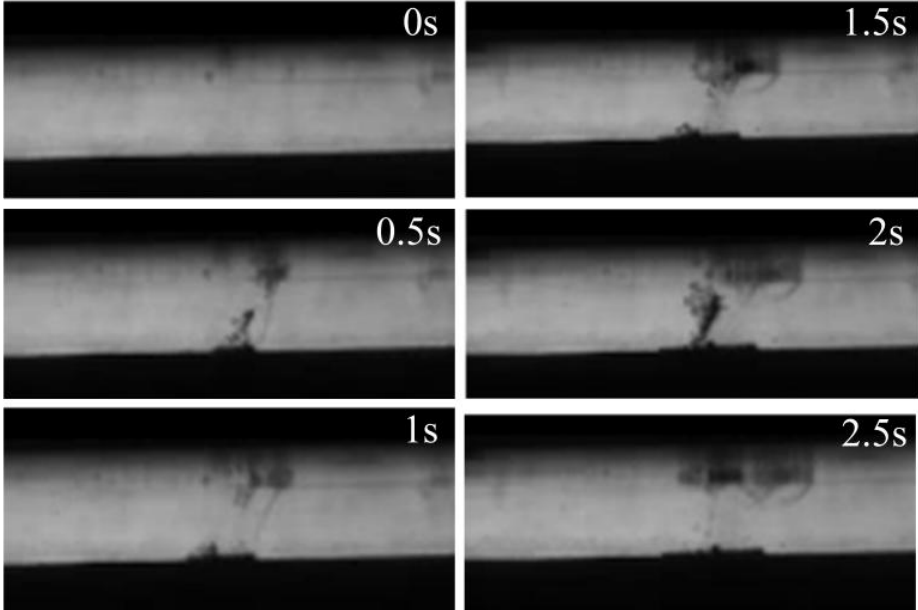
Figure 7. Time sequence diagrams of bubbles floating in 5.6 mol/L phosphoric acid solution.